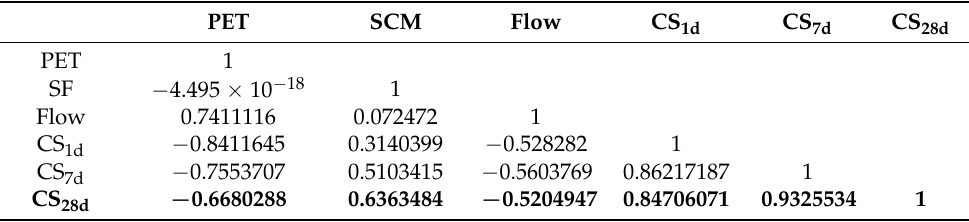
Table 3. Pearson correlation matrix for the inputs and output parameters CS 28d of waste PET/SCM blended cementitious grout.